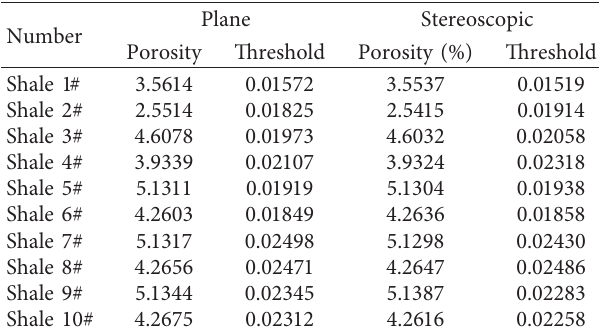
Figure 5: 3D reconstructed Table 2: Porosity and threshold of shale samples.